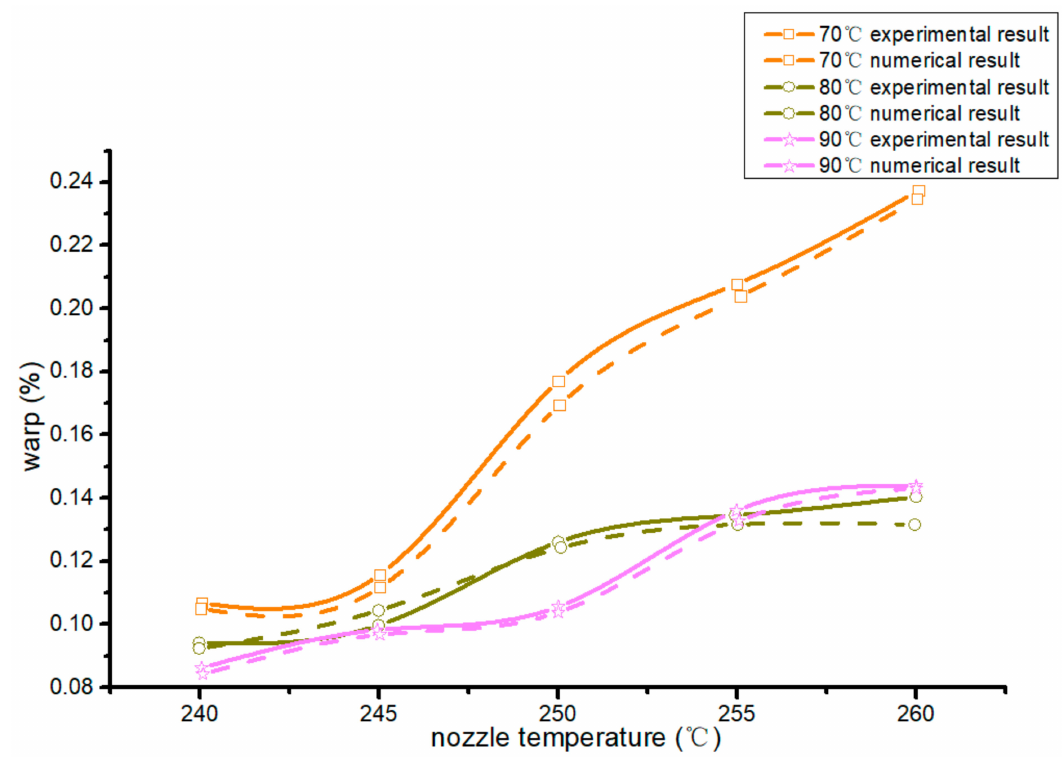
Figure 5. Numerical and experiment workpiece warpage at di ff erent hot-bed